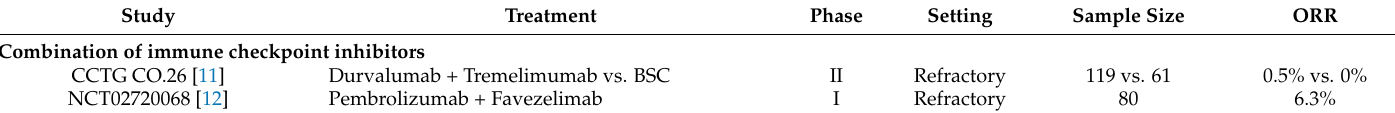
Table 1. Summary of clinical trials investigating the use of immunotherapy-based combinations for MSS